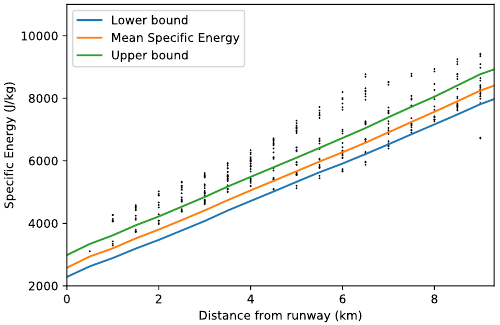
Figure 5. METAR-corrected barometric altitude against distance from runway threshold for landings and go-arounds on runway 32. Black dots represent aircraft positions at the time they went around and the three coloured lines represent the 2nd, 50th and 98th percentile altitudes across all aircraft that landed